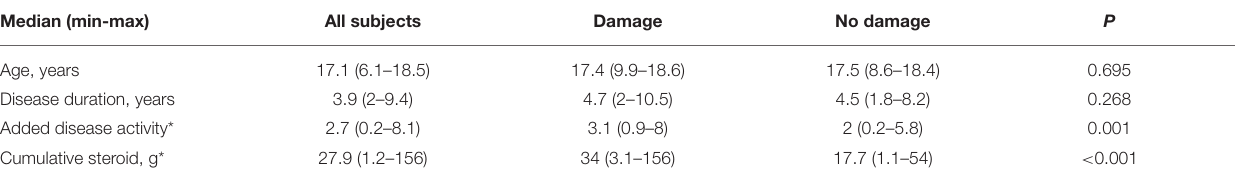
TABLE 2 | Main features of children at last visit, and by Damage (SDI ≥ 2) vs. No Damage (SDI ≤ 1). Median (min-max)